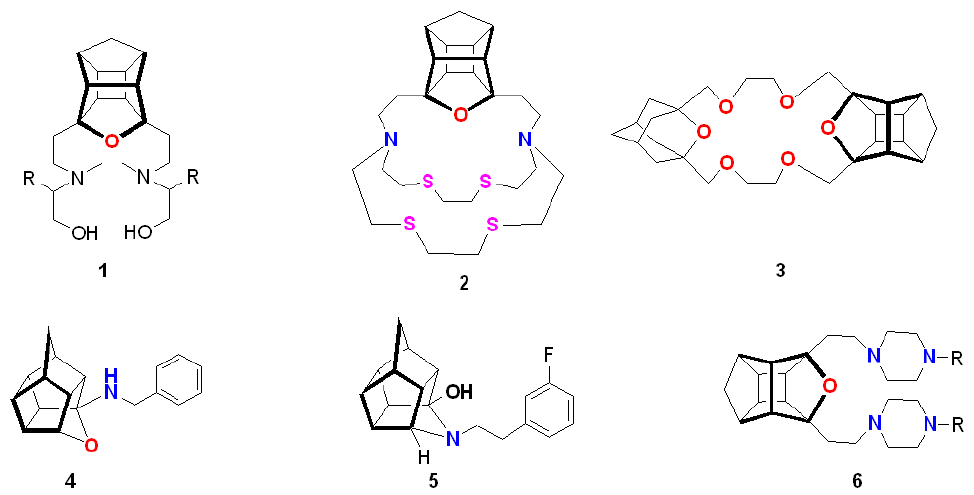
Figure 1. Examples of hetero-cages 1 – 6 useful in various fields.